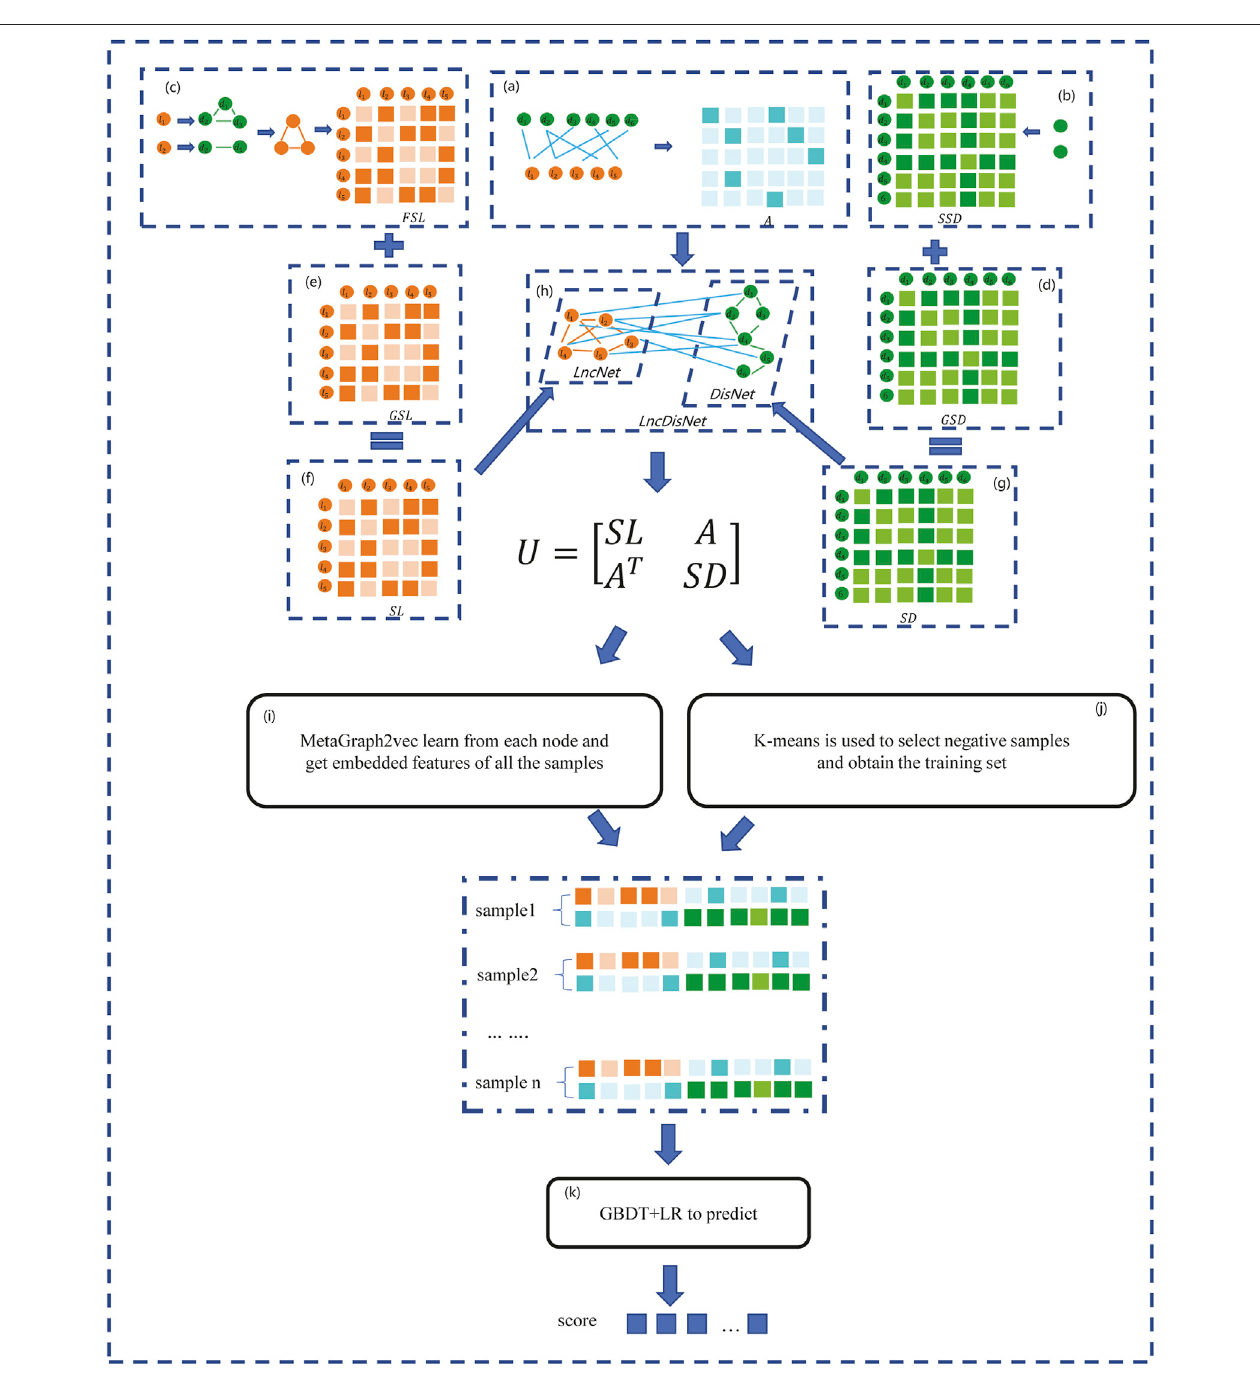
FIGURE1| FlowchartoftheGBDTLRL2D. (A) ObtainedtheassociationmatrixA. (B) CalculatedthediseasesemanticsimilaritymatrixSSD. (C) Calculatedthelong noncoding RNA (lncRNA) functional similarity matrix FSL. (D) Calculated the disease Gaussian interaction pro fi le kernel similarity GSD. (E) Calculated the lncRNA Gaussian interaction pro fi le kernel similarity GSL. (F) Obtained the lncRNA similarity SL. (G) Obtained the disease similarity SD. (H) Integrated three subnets A, SL, and SDtoconstructaglobalheterogeneousnetwork. (I) Obtainedtheembeddedfeaturesofnodes. (J) Selectedthenegativesampleandobtainedthetrainingset. (K) Trained the Gradient Boosting Decision Tree combined with logistic regression classi fi er (GBDT + LR).